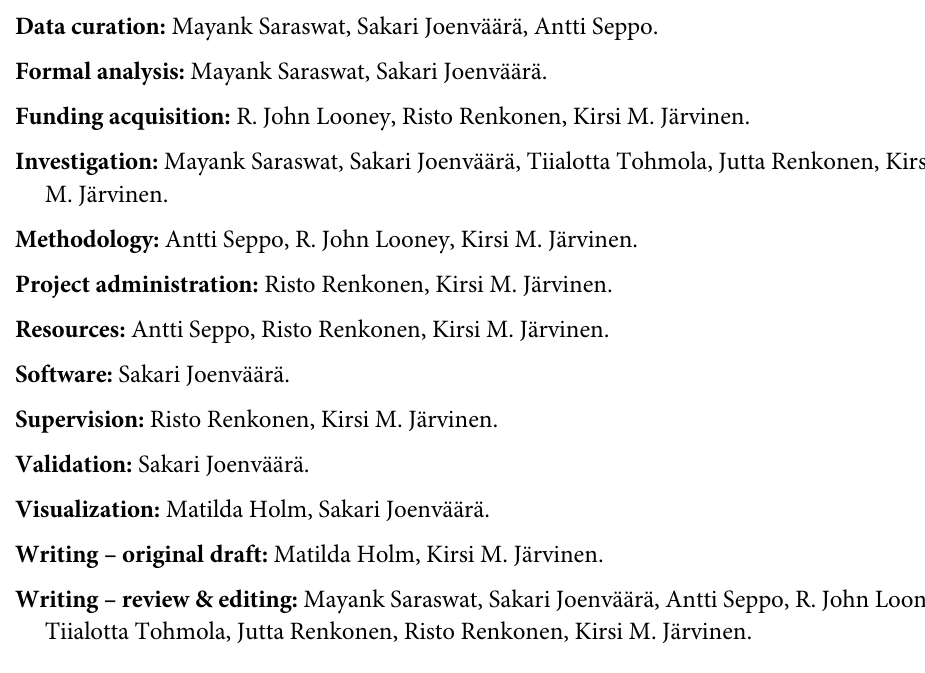
S6 Table. The milk samples analyzed in this study together with details regarding the mother’s community and the presence or absence of atopic disease in both mothers and